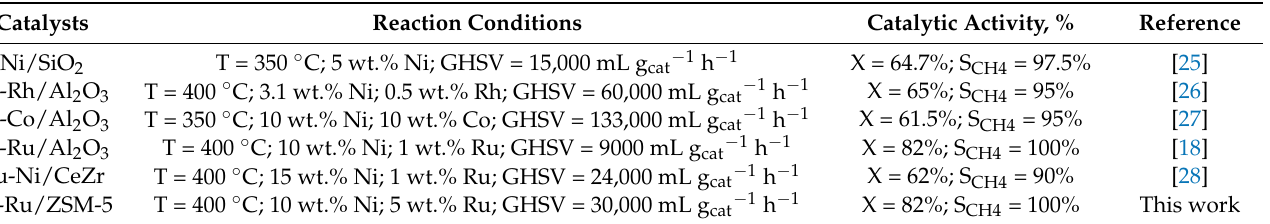
Table 5. Comparison of the catalytic activity of the supported catalysts from the literature studied in this